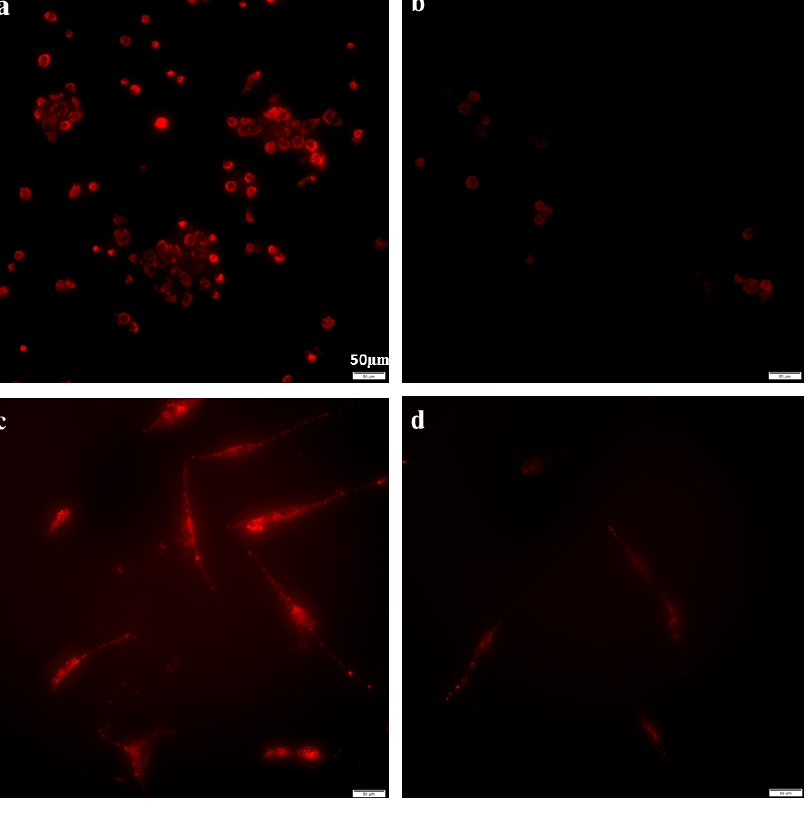
Figure 2. Azithromycin suppressed the mitochondrial membrane potential of MCF-12A cells and fibroblasts (20×). Mitochondria were stained with JC-1. ( a ) MCF-12A control; ( b ) MCF-12A treated with 188 µg/mL azithromycin for 24 h; ( c ) fibroblast control; ( d ) fibroblasts treated with 188 µg/mL azithromycin for 24 h.